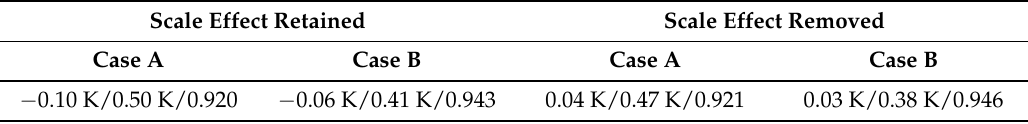
Table 6. MBD, RMSD, and Q values in evaluating the downscaled TIRS LST based on the original TIRS LST at the 100 m resolution.